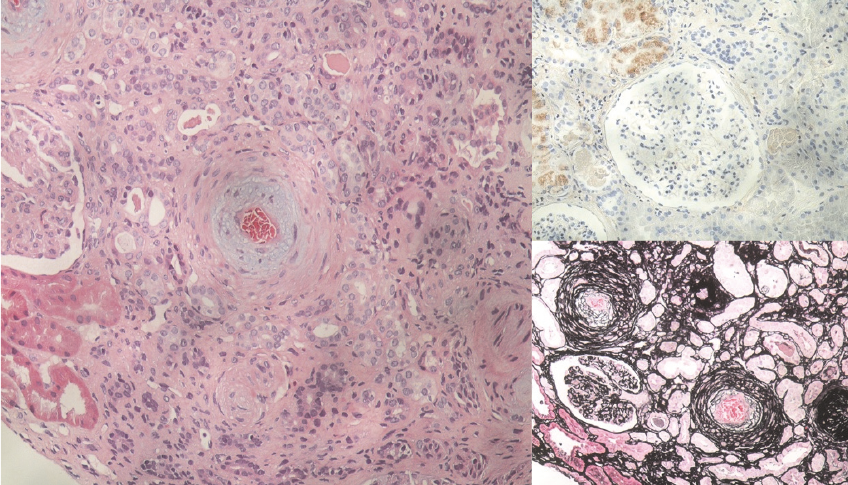
Figure 2: Renal biopsy. Left: arteriolar thickening and myxoid changes. Top right: negative immunofluorescence staining. Bottom right: onion skinning of arterioles on silver